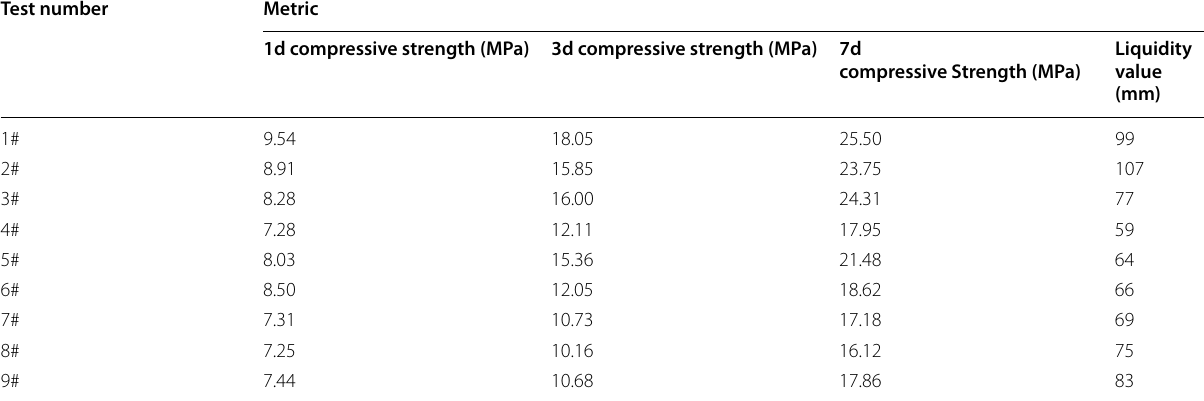
Table 9 Compressive strength and flubility of mortar Test number